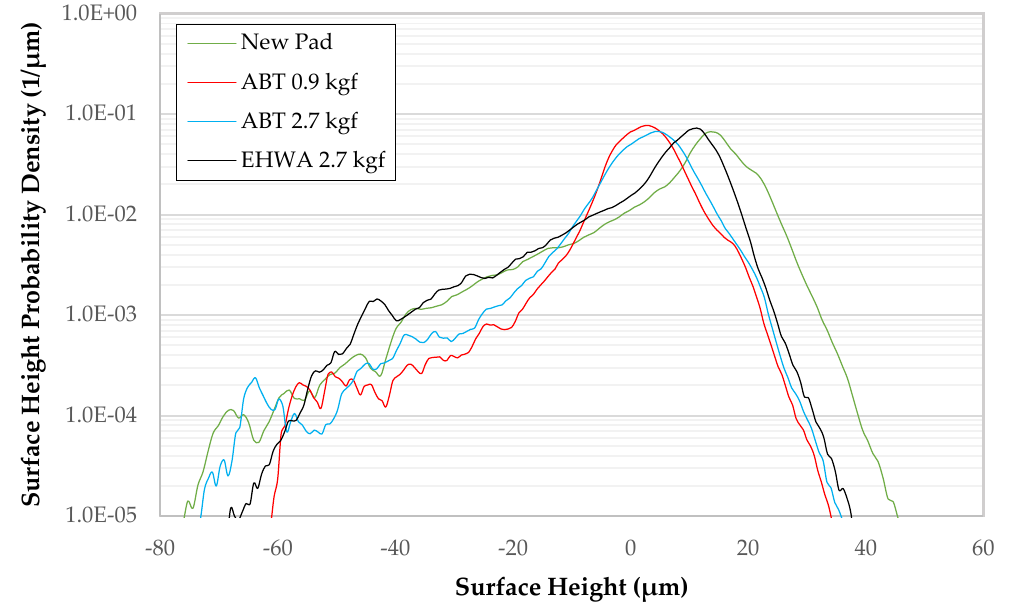
Figure 2. Surface topography of ( a ) brand-new pad; followed by pads broken-in for 30 min with ( b ) EHWA disc at 2.7 kg f , ( c ) ABT disc at 2.7 kg f and (d) ABT disc at 0.9 kg f .